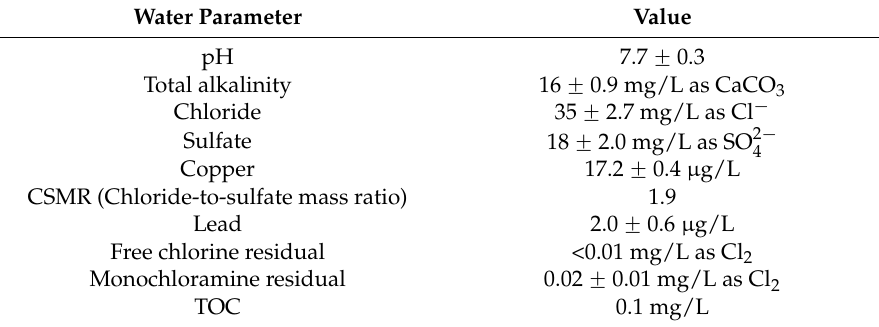
Table 1. Tap water